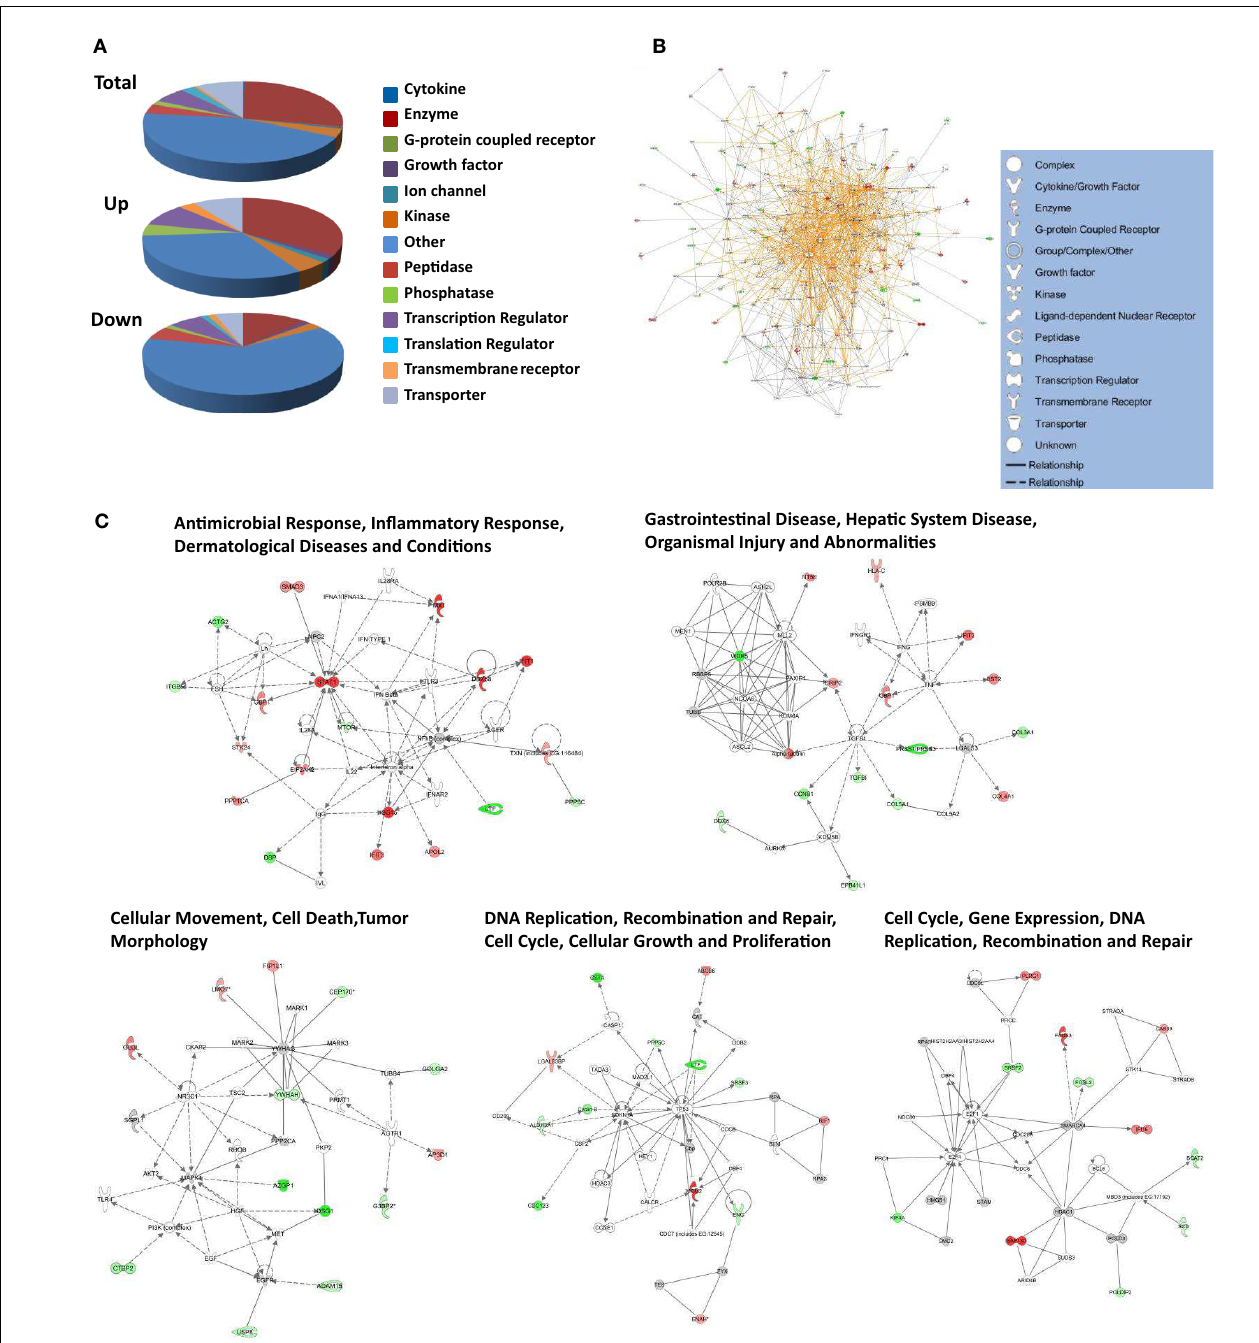
contained 11 or more “focus” molecules (molecules significantly up- or down-regulated), with pathway names indicated. Solid lines: direct known interactions; dashed lines: suspected or indirect interactions; red: significantly up-regulated proteins; pink: moderately up-regulated proteins; gray: proteins identified but not significantly regulated; light green: moderately down-regulated proteins; dark green: significantly down-regulated proteins; white: proteins known to be in network, but not identified in our